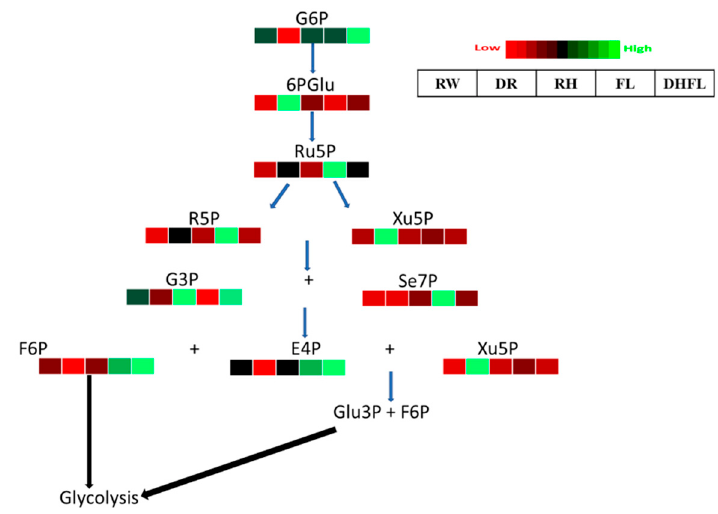
Figure 4. A heat map depicting the individual concentrations of intermediate metabolites of the pentose phosphate pathway in Mexican mint ( Plectranthus amboinicus ) plants under varying watering regimes (n = 3). Glucose-6-phosphate (G6P), 6-phosphogluconate (6PGlu), ribulose-5-phosphate (Ru5P), ribose-5-phosphate (R5P), xylulose-5-phosphate (Xu5P), glyceraldehyde-3-phosphate (G3P), sedoheptulose-7-phosphate (Se7P), fructose-6-phosphate (F6P), erythrose-4-phosphate (E4P), and glucose-3-phosphate (Glu3P). Metabolite concentrations in each block compartment are normalized across all data for an individual compound such that similar color intensities between compounds can represent widely differing concentrations. The red color represents a lower concentration, and the green color represents a higher concentration of a particular metabolite. The compartment was arranged from left to right as follows: regular watering (RW), drought (DR), resumption of regular watering after drought (RH), flooding (FL), and resumption of regular watering after flooding